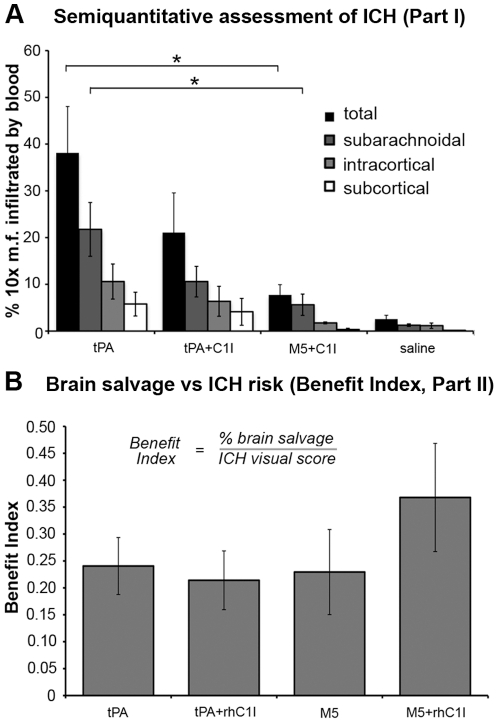
Semiquantitative ICH from Part I (A) and Benefit Index from Part II (B).A. ICH (%) by anatomical region in Groups 1, 2 (tPA) and 4 (M5+C1I). Group 3 could not be examined microscopically due to extensive hemorrhage. Extent of ICH in Group 4 was significantly (*p<0.05) less than in Group 1. B. Benefit Index defined as brain salvage divided by ICH complications. Brain salvage = control - post treatment ischemic volume/control ischemic volume. ICH complications = ICH score. The mean of the ratios and SEM for each treatment group is shown. Group 4 had the best Benefit Index but the difference from the other groups did not reach statistical significance (p = 0.29).